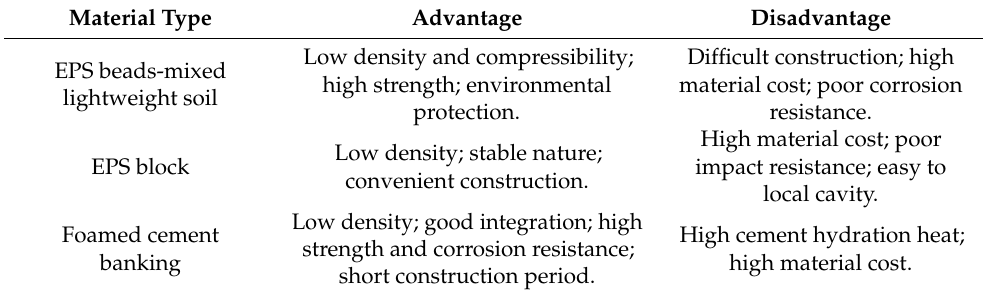
Table 1. Comparison of different lightweight fills.